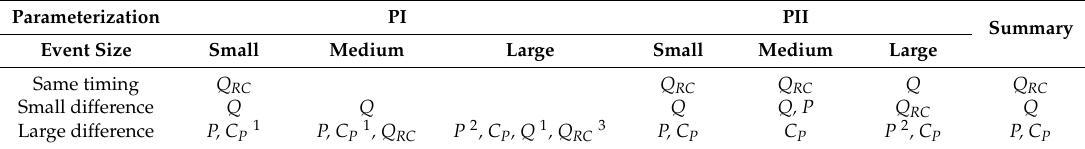
Table 4. Difference in the timing of the most informative sampling pairs when there are data errors ( I e_2 ) and when there are no data errors ( I 0_2